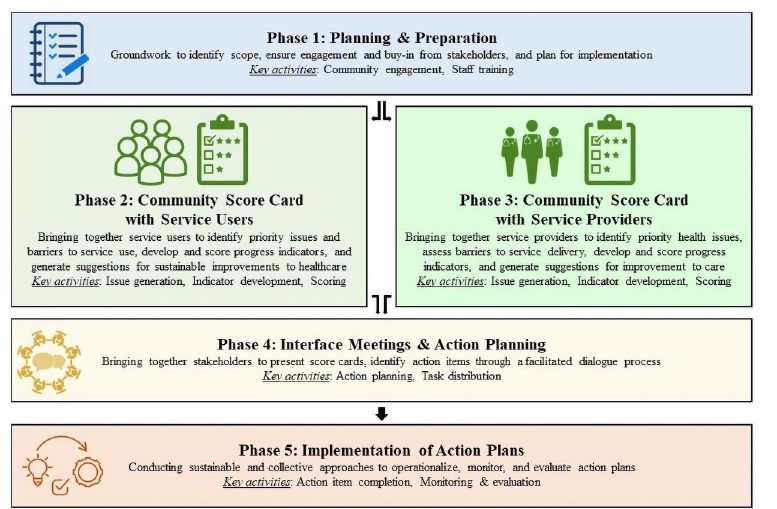
Fig 1. Core phases of the community score card